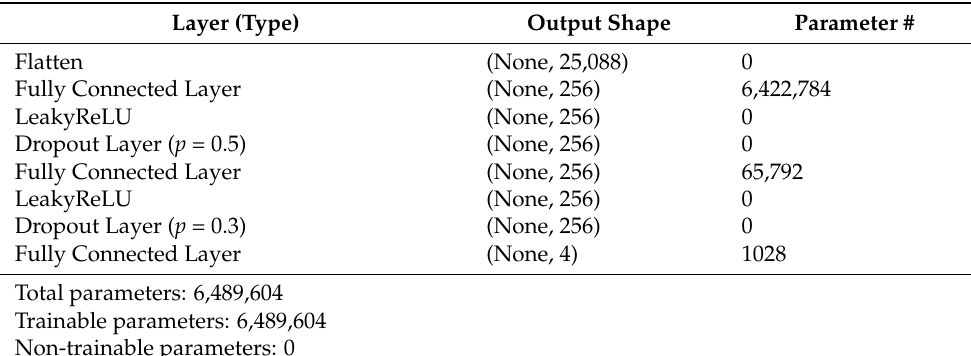
Table 1. CNN architecture on classification